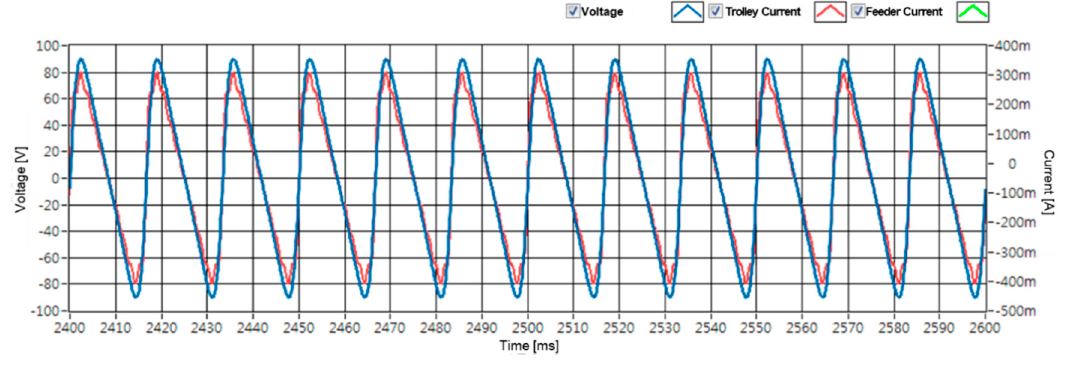
Figure 19. Current waveform with harmonics.